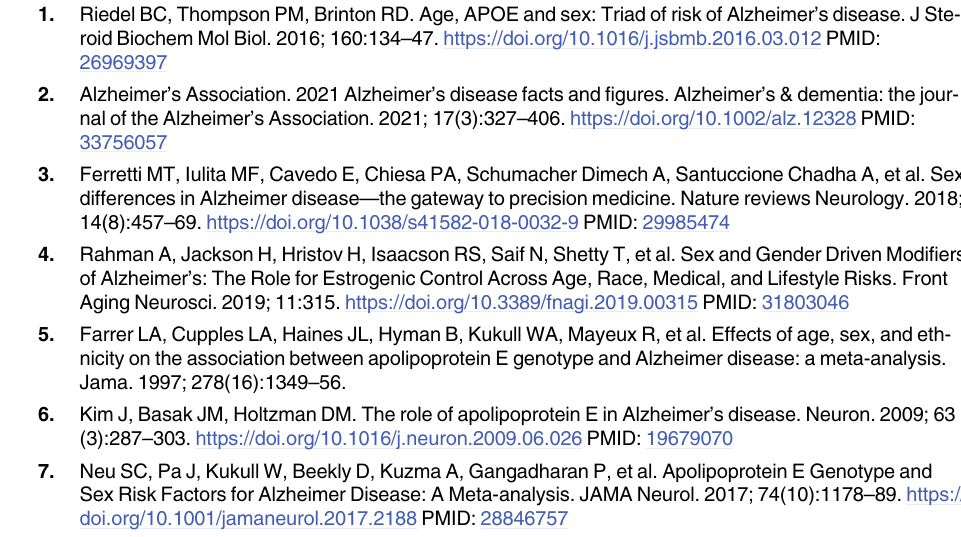
phosphomonoesters (PME) and phosphodiesters (PDE). P the left of PCr. Resonant peaks from the three phosphate groups of ATP ( γ -, α -, and β -ATP from left to right) are located to the right of PCr. A spectrum from the frontal lobe is shown in (A) a 55 year-old woman and (B) a 55 year-old